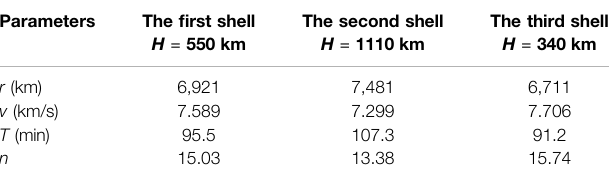
TABLE 1 | Radius, velocity, orbital period, and number of daily